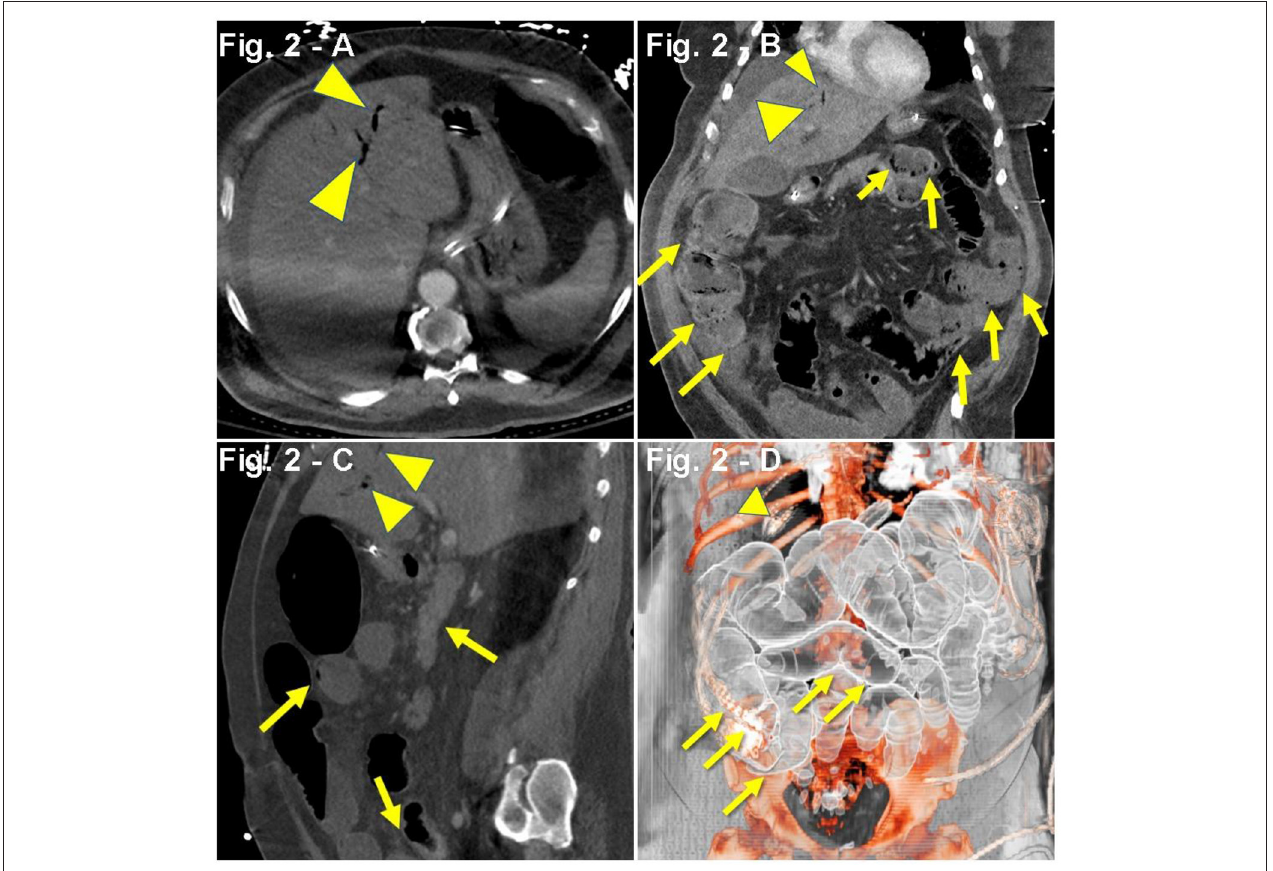
FIGURE 2 | (A–D) Case presentation of a 61-year-old male COVID-19 patient with respiratory failure on TCZ with rising lactate, abdominal ileus, abdominal CT with intravenous and oral contrast, (A) axial, (B) coronal, (C) sagittal, and (D) 3D reconstruction, with ileus and small and large bowel dilatation, with small bowel and cecal pneumatosis (yellow arrows) with portal gas (yellow arrowheads), and splenic and mesenteric vein gas.